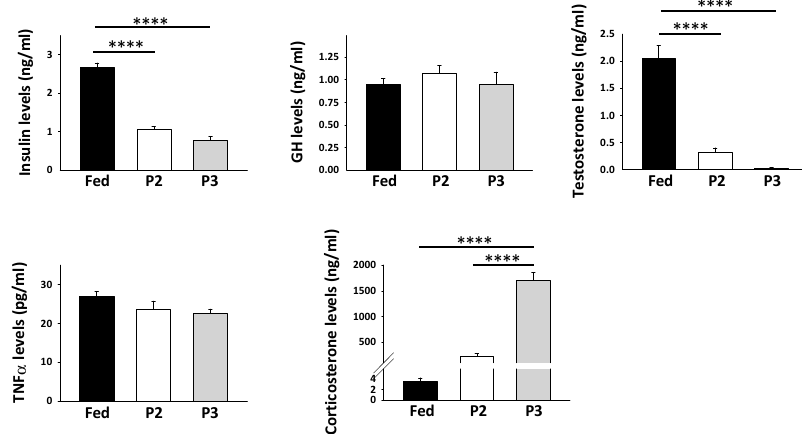
Figure 1. Plasma levels of hormones and growth factors (means ± SEM, N = 5/group). **** p -value < 0.0001 (one-way ANOVA and Tukey tests).